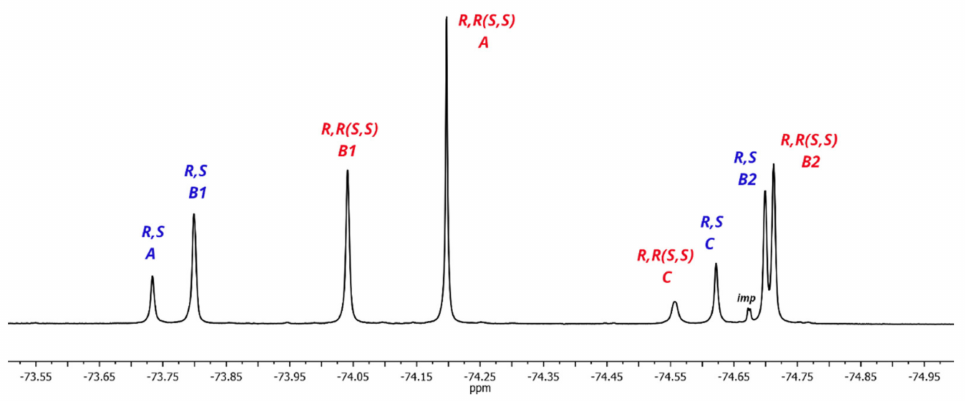
Figure 13. 19 F–{ 1 H}–NMR of 2 in CDCl 3 at 23 ◦